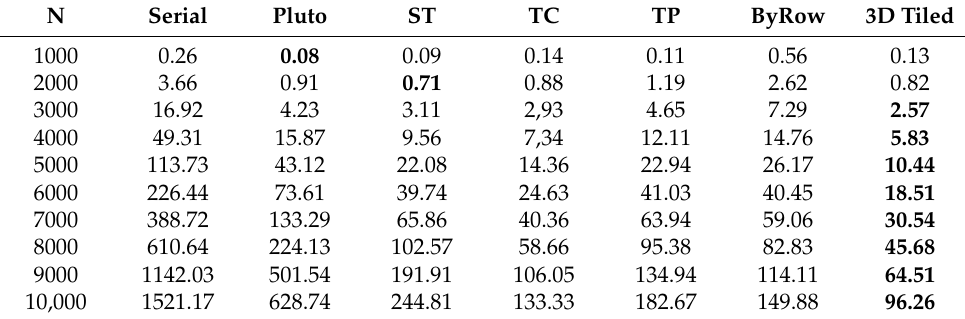
Table 3. Time in seconds for Intel i7-8700 and 12 threads (ST, TC, and TP denote the codes generated on the basis of the space-time, tile correction, and transpose approaches, respectively); best results of each row in